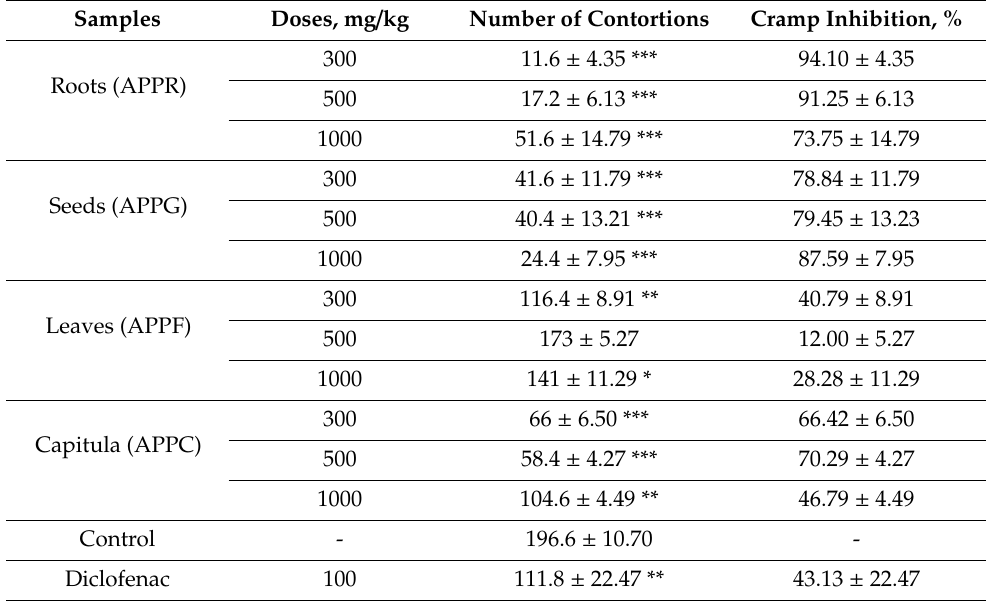
Table 1. Analgesic activity results of di ff erent parts of Anacyclus pyrethrum (L) on abdominal contractions induced in mice by acetic acid injection.